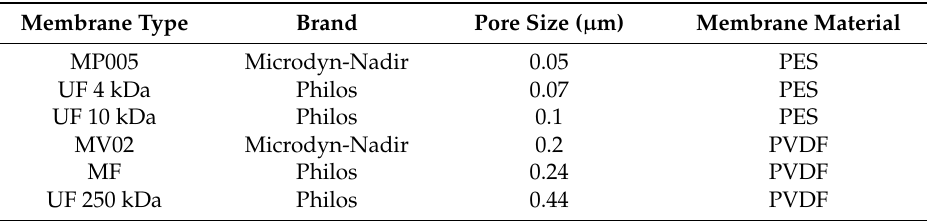
Table 2. Properties of microfiltration (MF) and ultrafiltration (UF) membranes. PES: polyethersulfone; PVDF: polyvinylidene